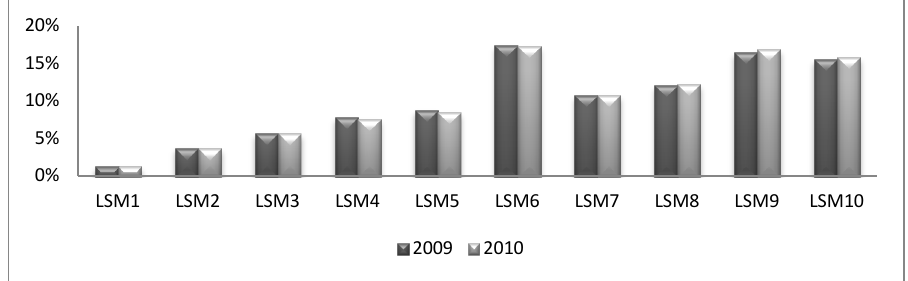
FIGURE 3: Cell C contract customers by LSM group Source: Cell C